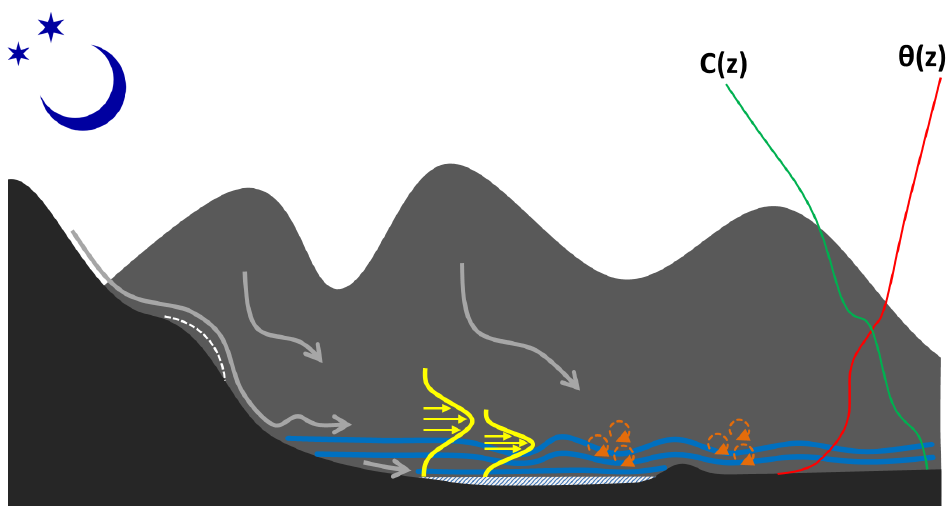
Figure 4. Nocturnal boundary-layer processes over mountainous terrain. Radiative cooling at the valley floor causes the formation of a stable layer near the ground (blue lines). Drainage flow develops along slopes (grey lines). Drainage flow typically has a low-level wind maximum very close to the surface, but it can detach from the ground above stable layers or at convexities in the slope profile (white dashed line). Sheltered areas beneath separated flow are typically less turbulent. If the valley geometry is favourable (for instance, if the cross-section becomes narrower or there are humps on the valley floor), cold air pools and eventually fog may form (white shaded area). If a cold-air pool is present, the down-valley flow typically flows over it (yellow arrows and profiles). Gravity waves may propagate along the top of the surface-based stable layer, forming undulations along the down-valley jet. Increased wind shear at wave troughs enhances turbulence, leading to localized and intermittent mixing episodes (orange whirls). Layering in the profiles of potential temperature and scalar concentration is often observed. After days with strong insolation, a well-mixed near-neutral residual layer may be present in the valley core. The vertical scale of the figure is exaggerated near the valley